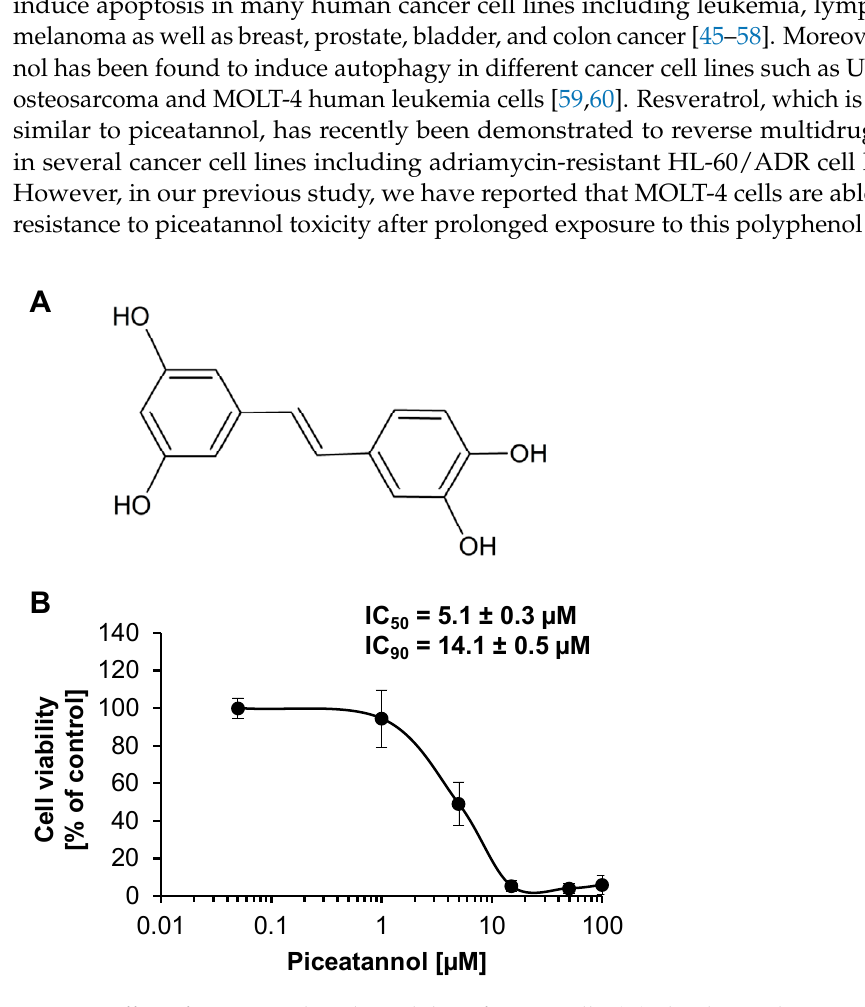
Figure 1. Effect of piceatannol on the viability of HL-60 cells. ( A ) The chemical structure of piceatannol. ( B ) Neutral red uptake assay. HL-60 cells were incubated in the absence (control) or presence of piceatannol for 72 h. Data are presented as means ± SD of three independent experiments in duplicates.